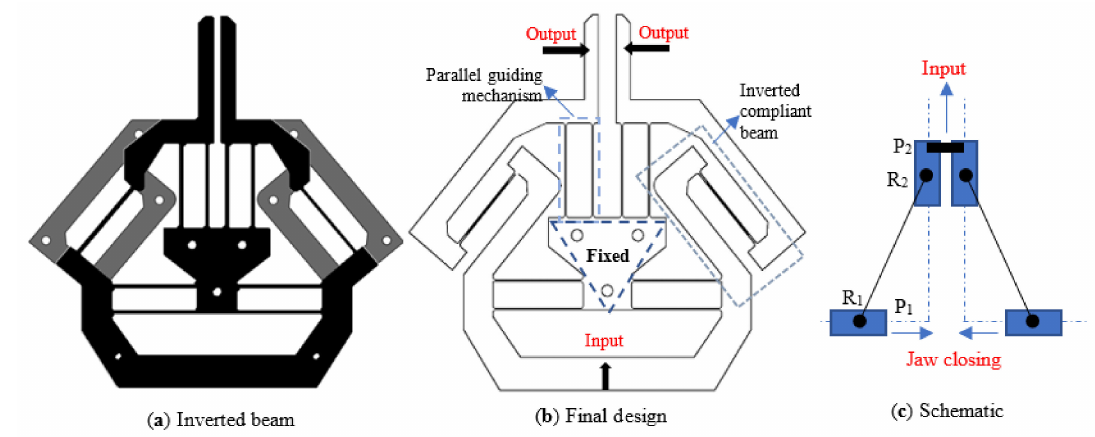
Figure 3. The final design of the compliant